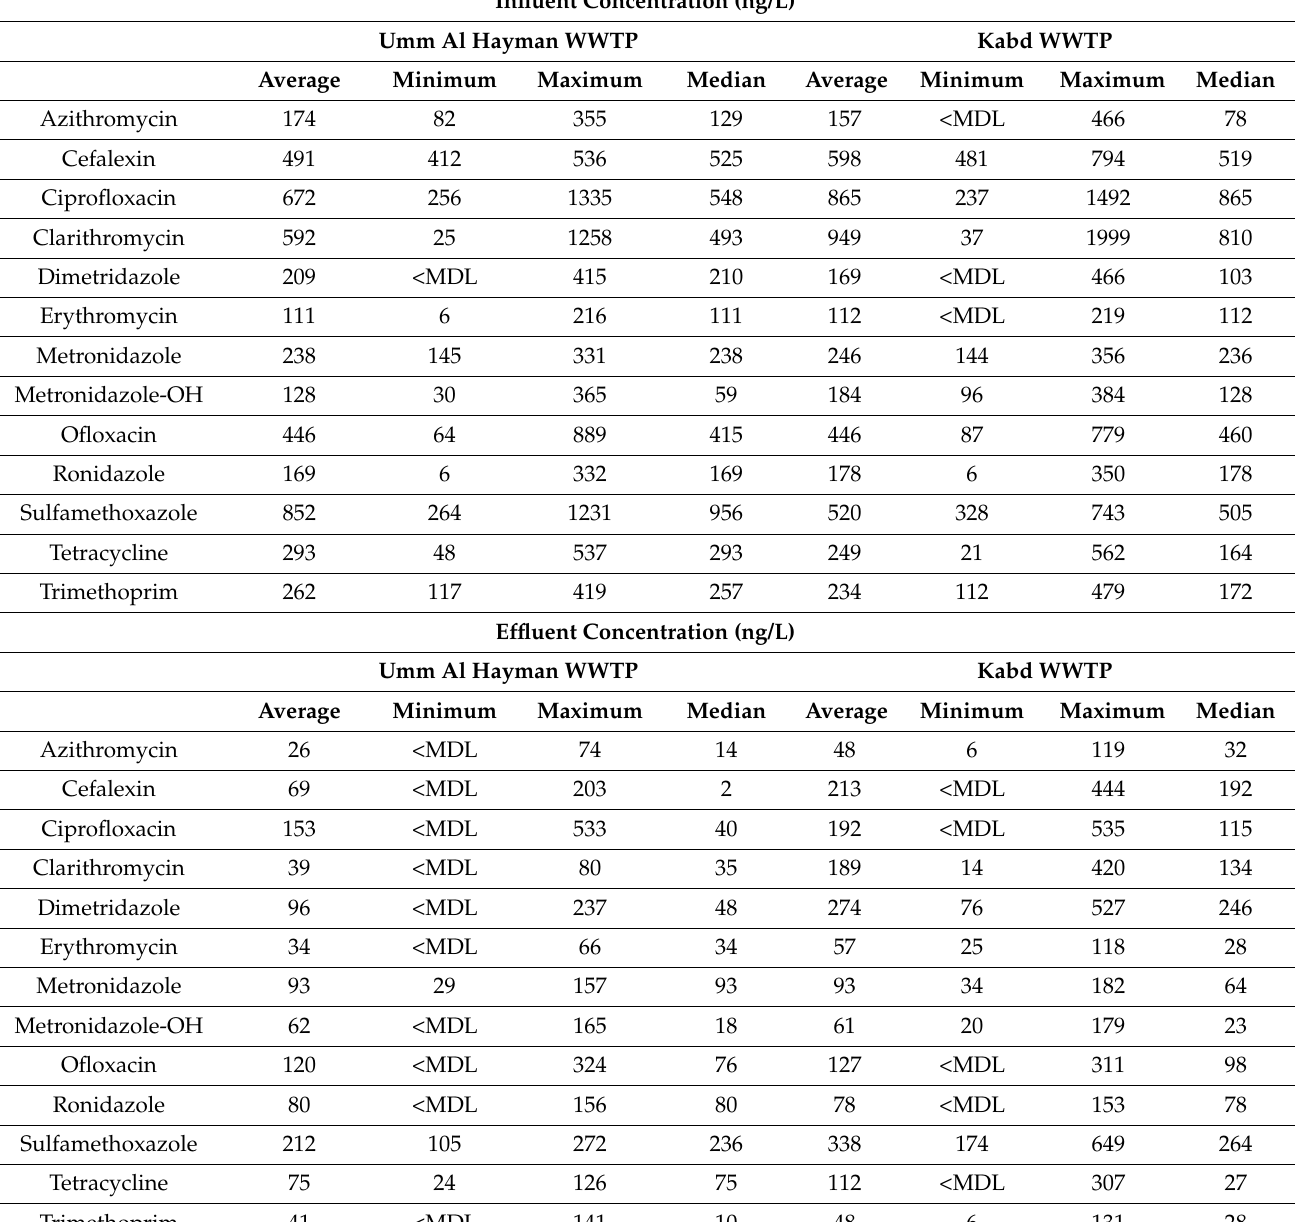
Table 3. Summary of average, minimum, maximum, and median concentrations of antibiotics ( n = 4), expressed in ng/L, in influents and effluents of the two wastewater treatment plants in